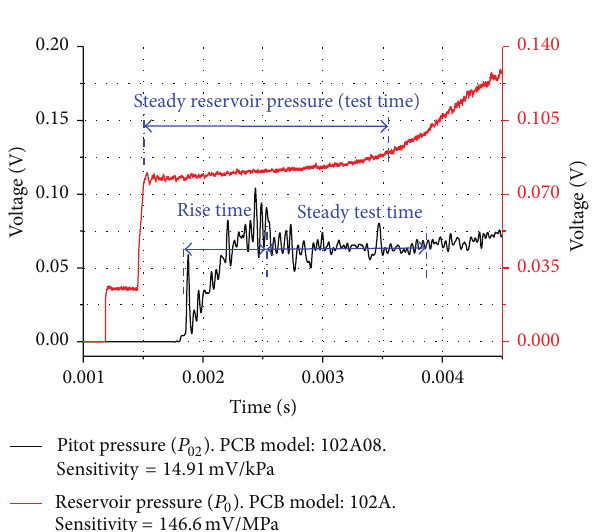
test time in the tunnel test section are indicated on the pressure signals. The pressure signals were acquired using the piezoelectric pressure transducers of PCB Piezotronics (USA). The model numbers and sensitivities of the pressure transducers are indicated in the